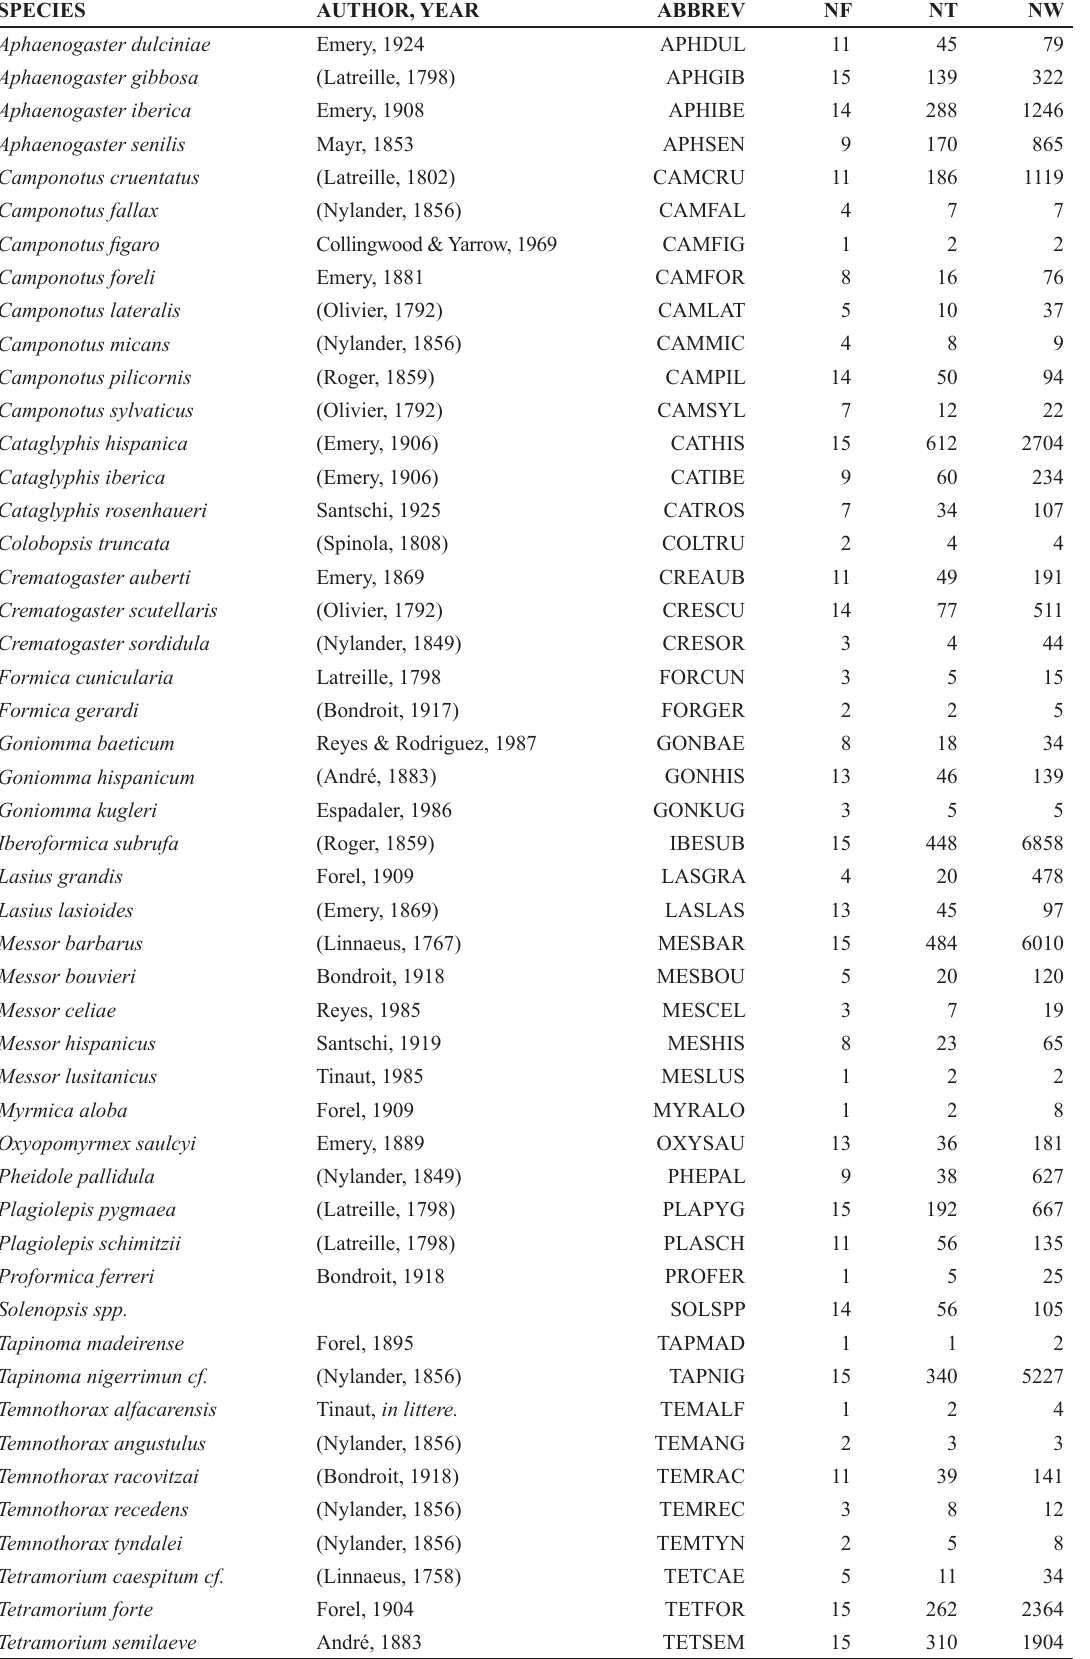
Table 2 . List of the species of ants and their abbreviations. Number of farms where each species was located (NF); total number of traps occupied by each species (NT); total abundance of workers-individuals